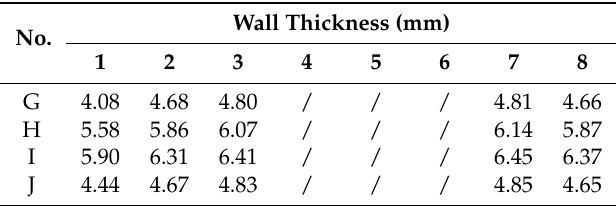
Table A3. Testing results for Fields G–J in Sichuan